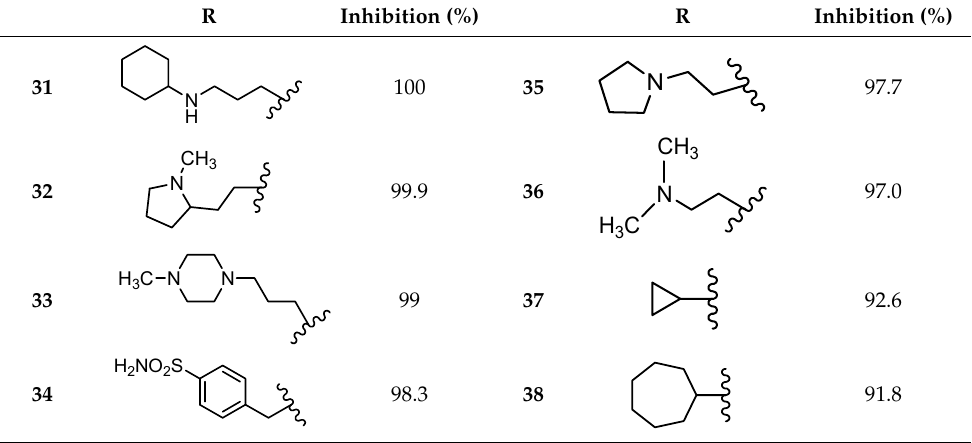
Table 4. Structural details and HCMV polymerase inhibition values of compounds 39 – 42 (adapted from [86]).